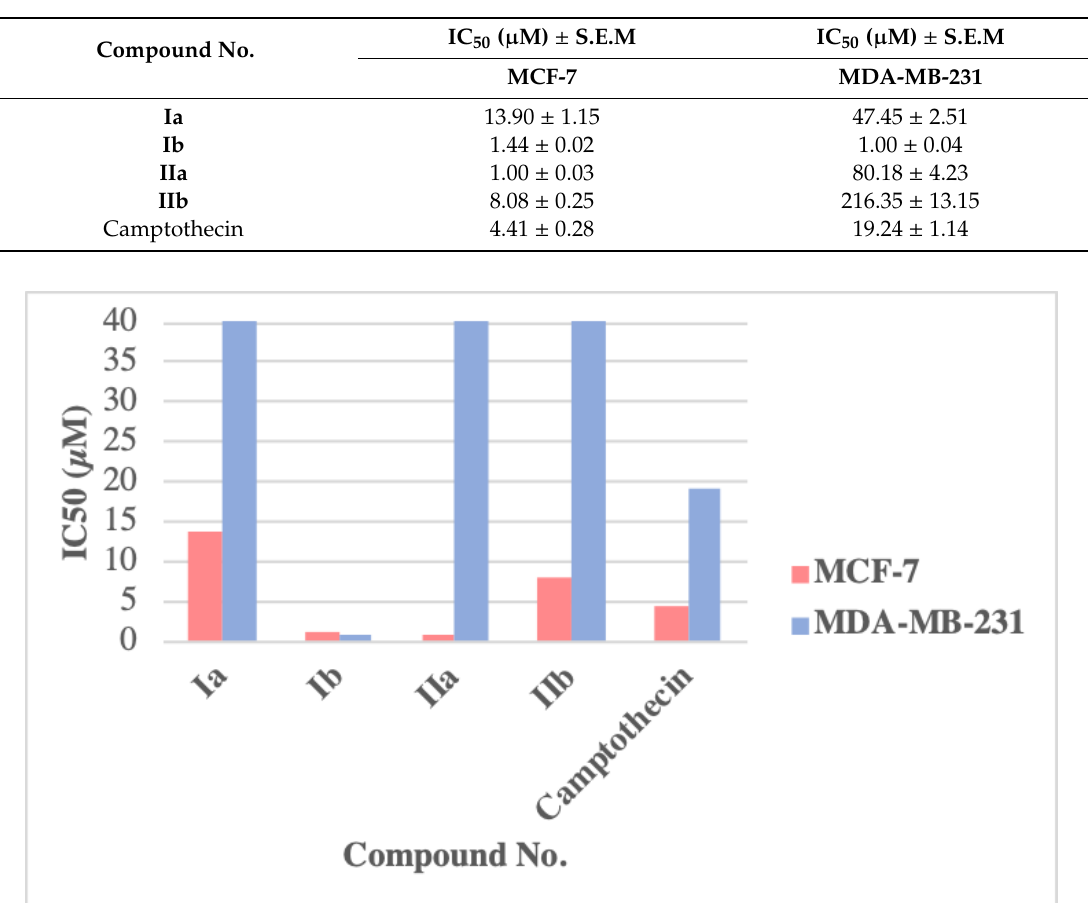
Figure 2. Cytotoxicity of the intermediates Ia , b , IIa , b , and camptothecin.